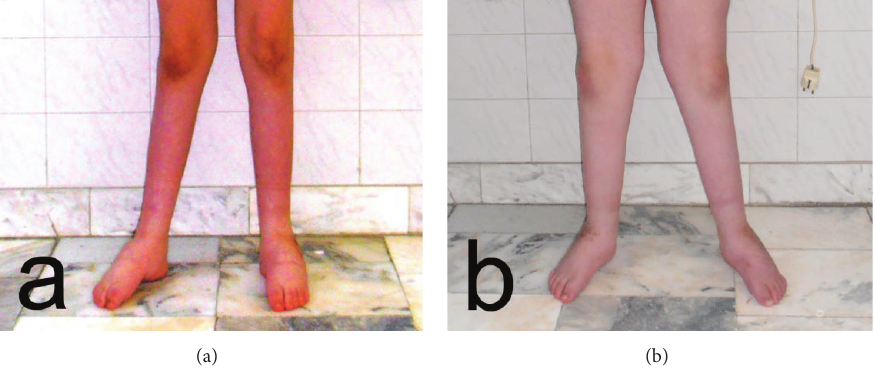
Figure 5: Postoperative photograph of the patients: (a) sister and (b) brother with hereditary motor and sensory neuropathy type I.